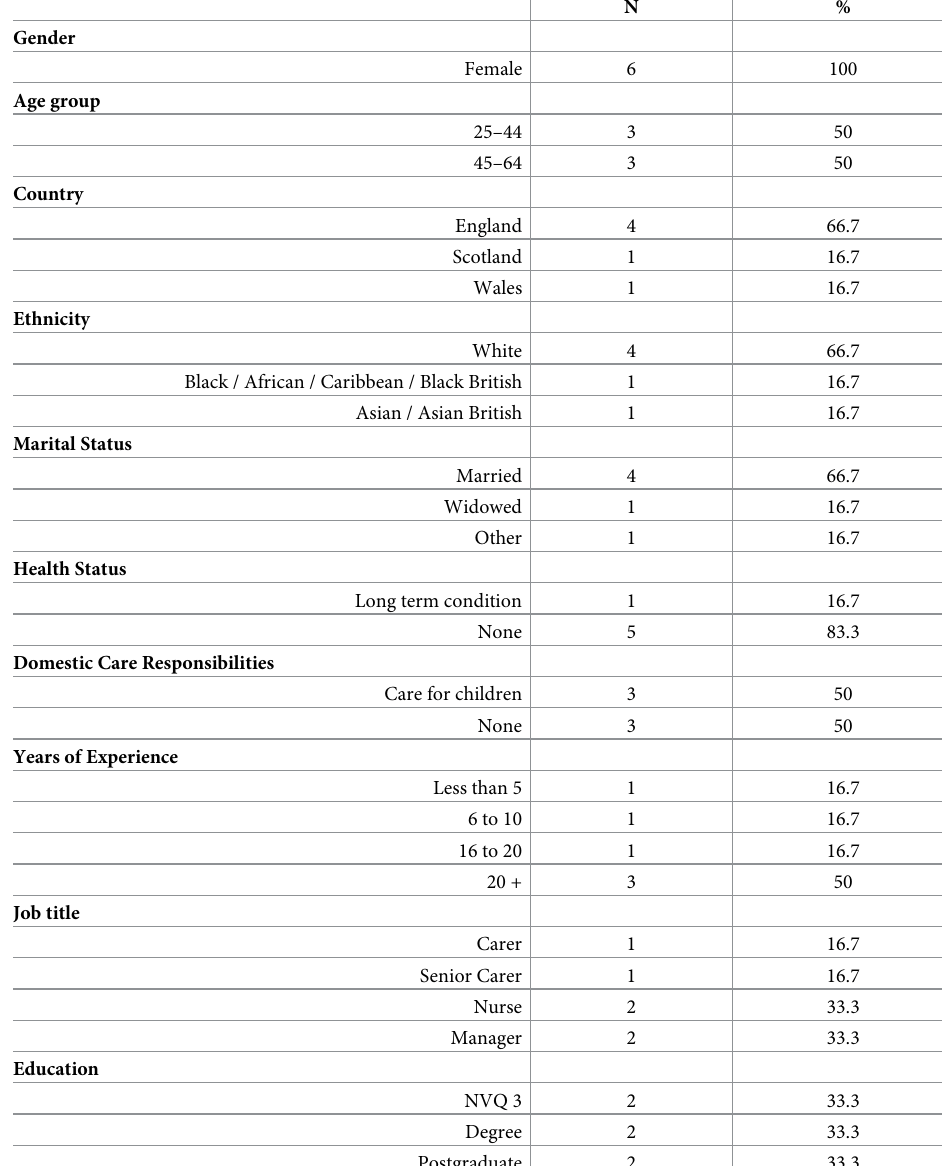
Table 5. Phase 2 demographic